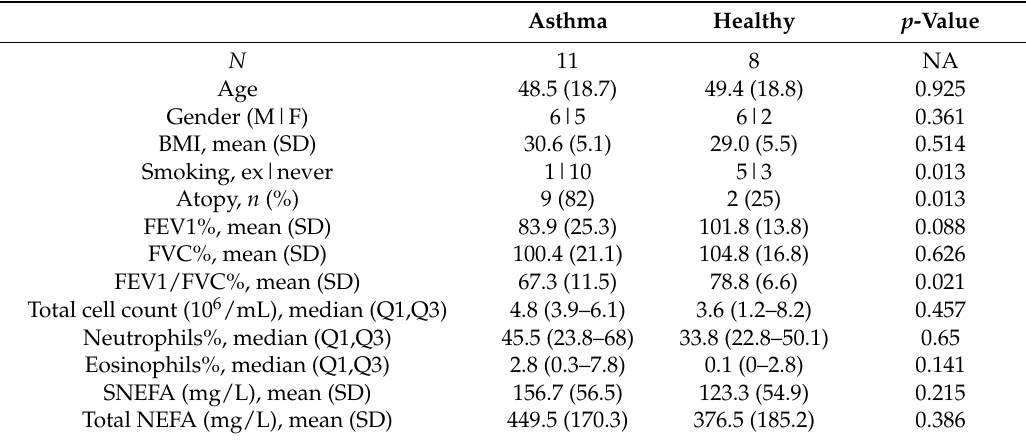
Table 1. Clinical characteristics of asthmatics and healthy